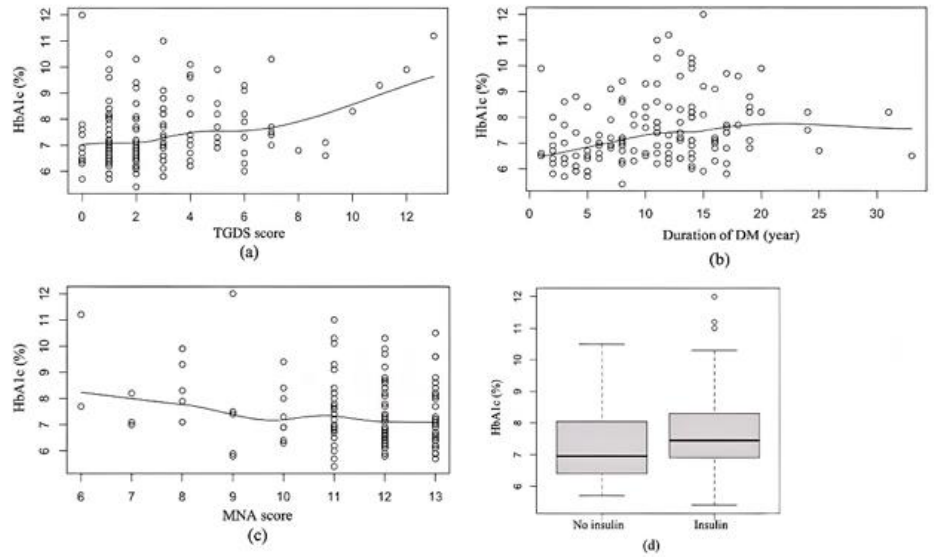
Figure 2. Baseline correlations between HbA1c and ( a ) TGDS score, ( b ) duration of DM, ( c ) Mini Nutritional Assessment (MNA) score and ( d ) insulin (no insulin vs. insulin).